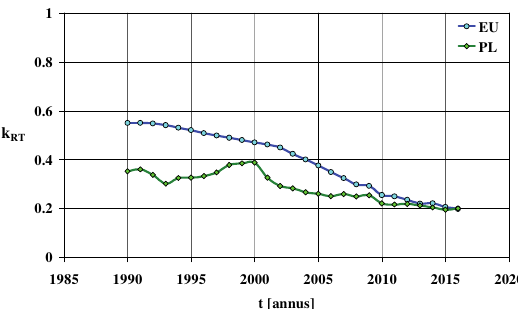
Fig. 13. Share of annual emission from motor vehicles comparing to the total annual emission for carbon monoxide: in Poland – PL and in the European Union – EU in years 1990–2016 The average share of annual emission of pollutants from motor vehicles in relation to the total annual emis- sion is: – for the European Union – 0.228: from 0.087 – for particular matter to 0.414 – for nitrogen oxides, – for Poland – 0.141 – from 0.026: for particular matter to 0.286 – for carbon